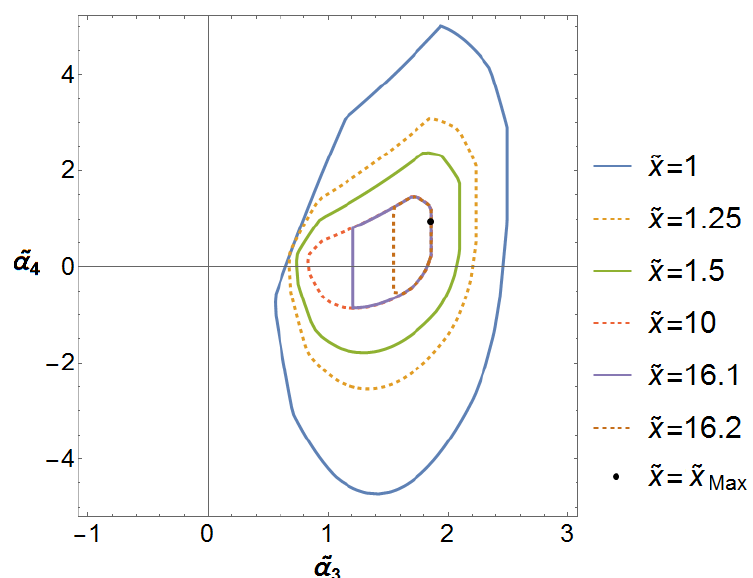
JHEP03(2020)097 Figure 12 . The allowed regions in (~ (cid:11) 3 ; ~ (cid:11) 4 ) plane in the case of (cid:13) = 1 and ~ (cid:12) 3 = (cid:0) 0 : 77 ; ~ (cid:12) 4 = (cid:0) 0 : 06. The island shrinks to a point at (~ (cid:11) 3 = 1 : 85 ; ~ (cid:11) 4 = 0 : 95) for the maximum value of ~ x max = 16 : 29. For these values of (cid:13); ~ x the constraints on (~ (cid:11) 3 ; ~ (cid:11) 4 ) come mainly from the hh ! hh scattering. Figure 13 . The allowed parameter region in (~ x; (cid:13) ) plane obtained from the combined constraints from all three scattering processes. For any (cid:12)xed value of (cid:13) , the maximal value for ~ x is obtained by increasing ~ x until the allowed region in the parameter space of ~ (cid:11) 3 , ~ (cid:11) 4 , ~ (cid:12) 3 and ~ (cid:12) 4 shrinks to a point. The blue line represents the maximum value of ~ x for a given (cid:13) . A linear relation between ~ x max and (cid:13) is to be expected and is directly related to the presence of another spin-2 pole. { 27